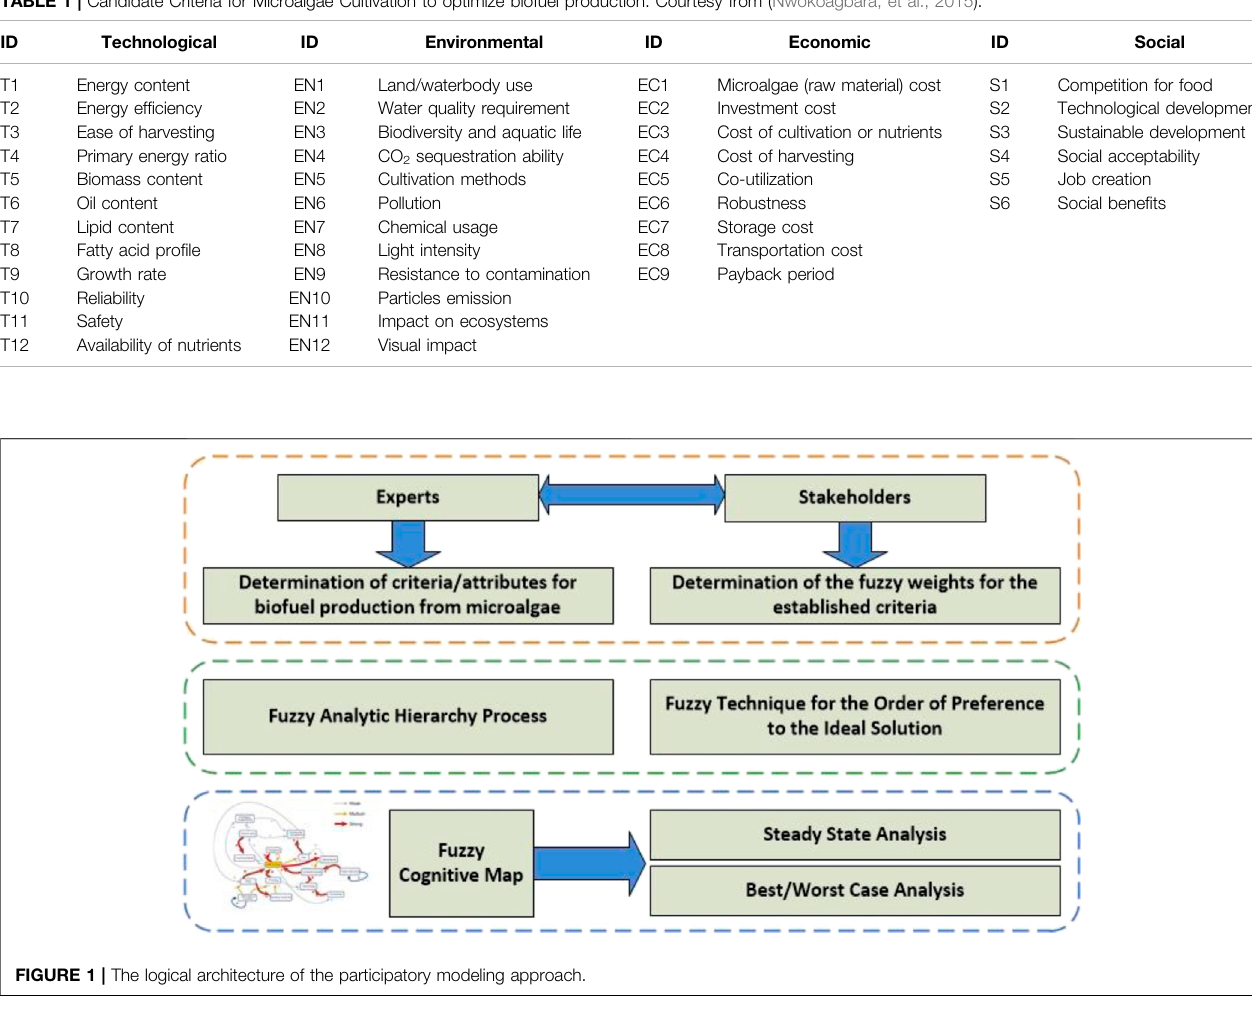
TABLE 1 | Candidate Criteria for Microalgae Cultivation to optimize biofuel production. Courtesy from (Nwokoagbara, et al., 2015).